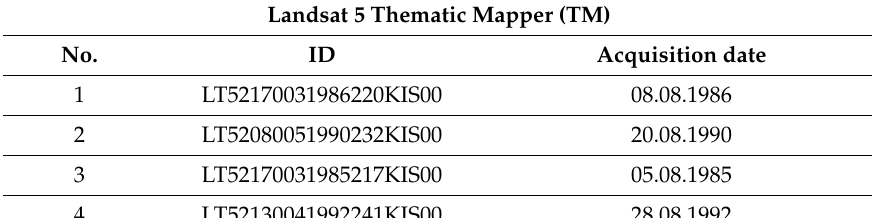
Table 1. Landsat satellite scenes and digital elevation model (DEM) files used in the analysis including the source material used in Figure